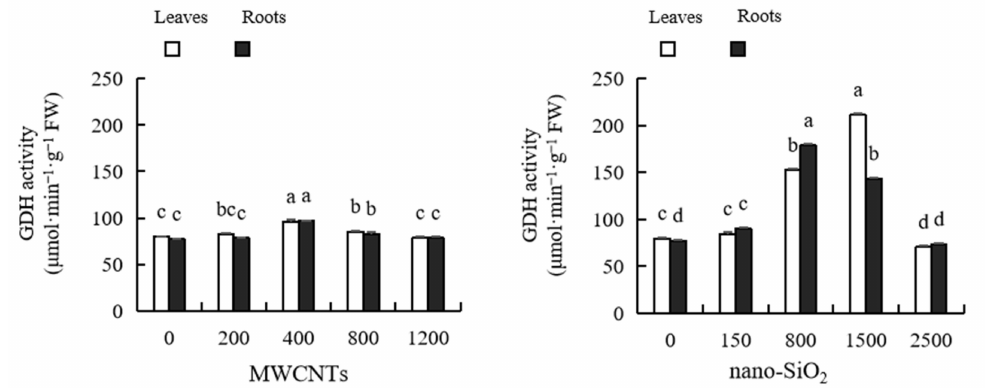
Figure 11. Effect of different concentrations of MWCNTs and nano-SiO 2 on GDH activity in maize. Note: Data are expressed as mean ± standard deviation. Different letters within the same column indicate significant difference at 5%